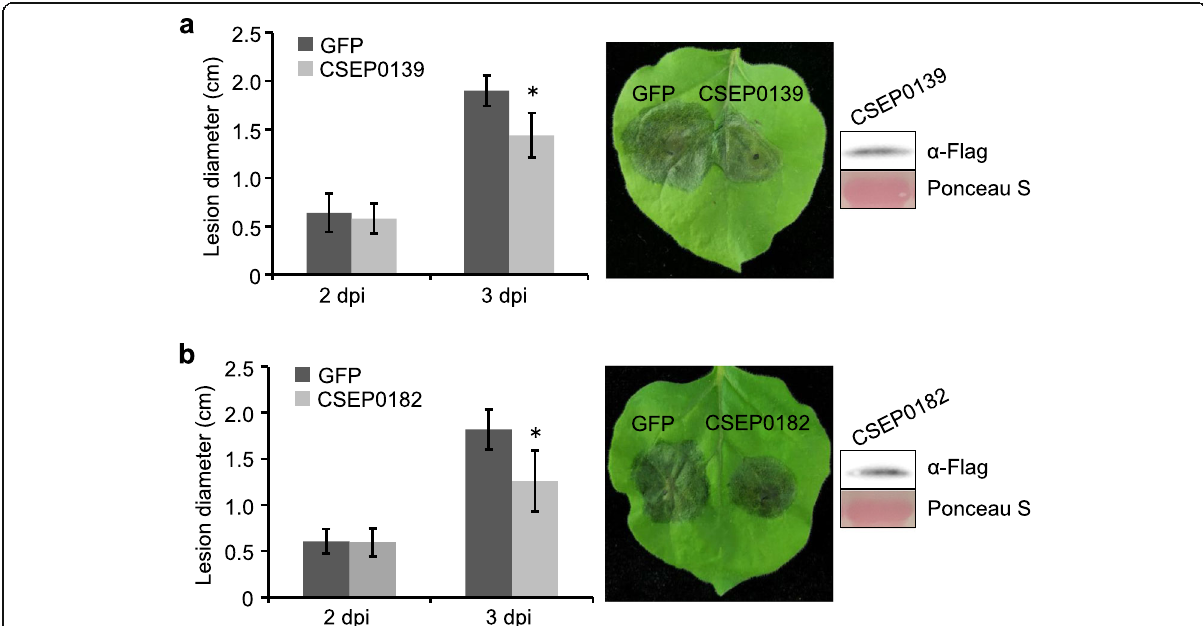
Fig. 6 Expression of CSEP0139 and CSEP0182 reduces the size of lesions caused by Botrytis cinerea in N. benthamiana . CSEP0139 (a) or CSEP0182 (b) was expressed in N. benthamiana by agroinfiltration, with GFP construct as control. B. cinerea was inoculated at 24 h after agroinfiltration with GFP or indicated CSEP in the middle of pre-infiltrated areas, and pictures were taken at 3 dpi. The lesion size caused by B. cinerea infection was measured as the diameter of infected area at 2 and 3 dpi, and shown as the average values and SE from three independent experiments, each with 10 leaves. The asterisk indicates significant difference at P < 0.05 by Student ’ s t